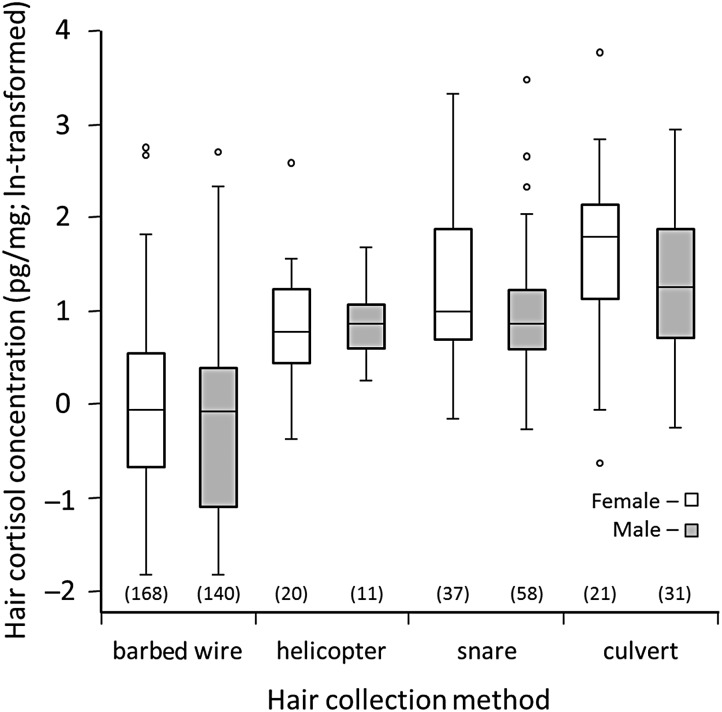
Box plot comparison of hair cortisol concentration (HCC) among female and male brown bears (n = 486) sampled by barbed-wire hair snagging (barbed wire) or by clipping hair following capture by remote drug delivery from helicopter (helicopter), leg-hold snare (snare) or culvert trap (culvert). The top and bottom of each box represents the first and third quartiles (Q1 and Q3), while the inside line represents the median. The vertical line goes to the first data points before the ‘1.5’ cut-off above and below the box. The ‘1.5’ cut-off above is calculated as Q3 + 1.5 × (Q3 − Q1) and the ‘1.5’ cut-off below is calculated as Q1 − 1.5 × (Q3 − Q1). The points represent values (outliers) lying outside of the range defined by the vertical lines. Sample sizes for sex × hair collection method categories are presented in parentheses below each box plot.